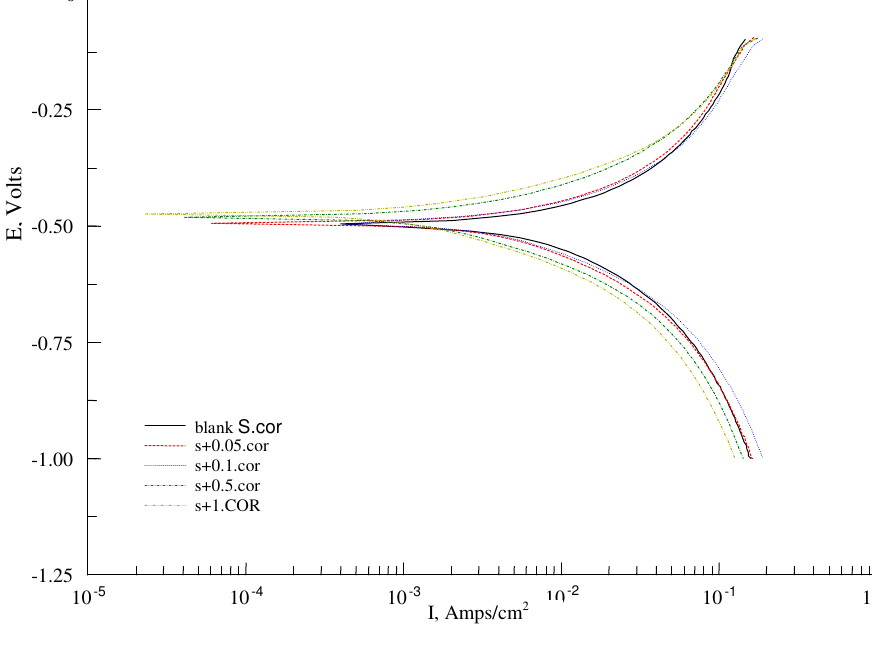
Figure 1 . Potentiodynamic polarisation of mild steel in 1N H Table 3 . Impedance parameters for mild steel in 1N H